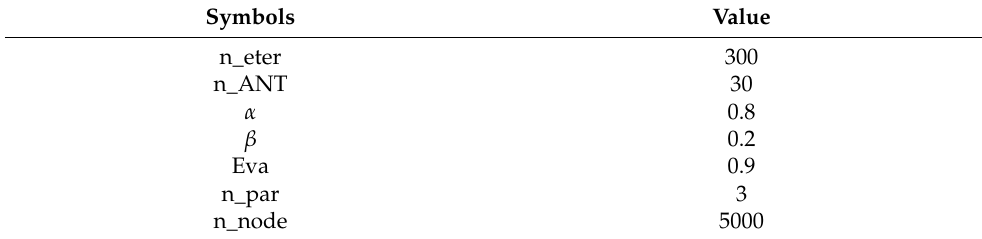
Table A1. The ACO Algorithm parameters.